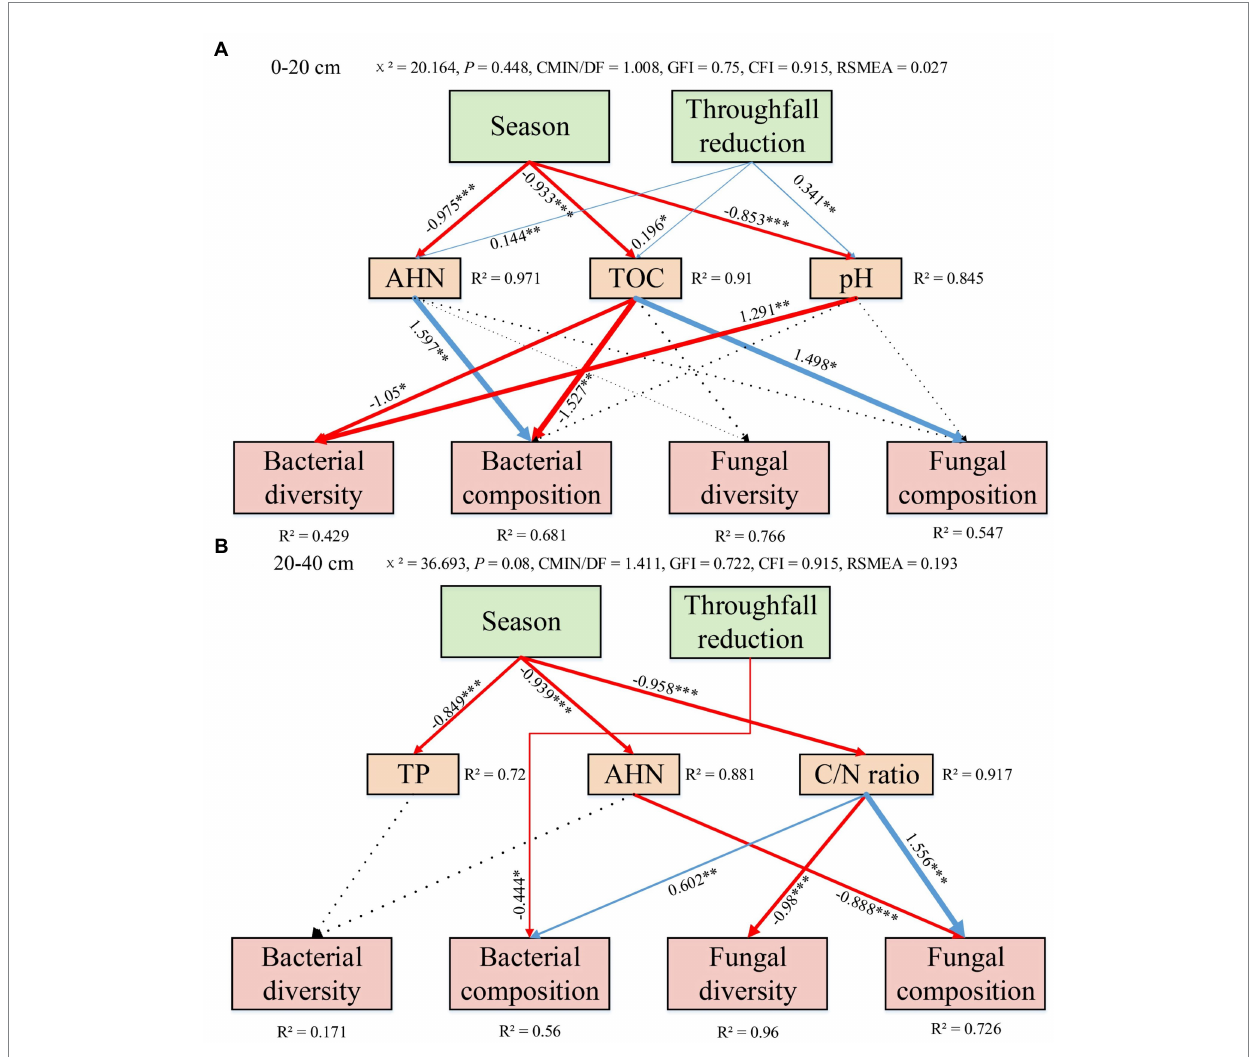
FIGURE 9 Structural equation model (SEM) of season variation and throughfall reduction effect on diversity and composition of soil bacterial and fungal communities at 0–20 cm (A) and 20–40 cm (B) soil depth. Blue arrows indicate positive effects, and red arrows indicate negative effects. The thickness of the line of the arrow indicates the correlation strength. The number next to the arrow represents the standardized path coefficient, indicating the correlation strength of the two factors. *, **, and *** indicate statistical significance levels at p < 0.05, p < 0.01 and p < 0.001, respectively. AHN, alkali hydrolyzed nitrogen; TOC, total organic carbon; TP, total phosphorus; C/N ratio, the ratio of total organic carbon and total